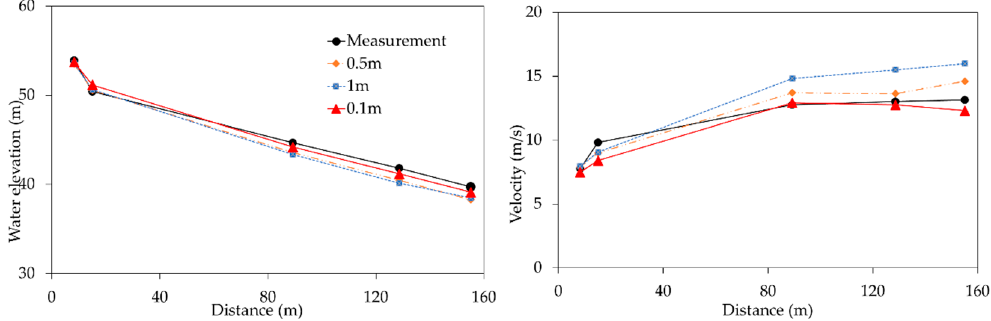
Figure 6. Water elvevation and velocity profiles in the design scenario.